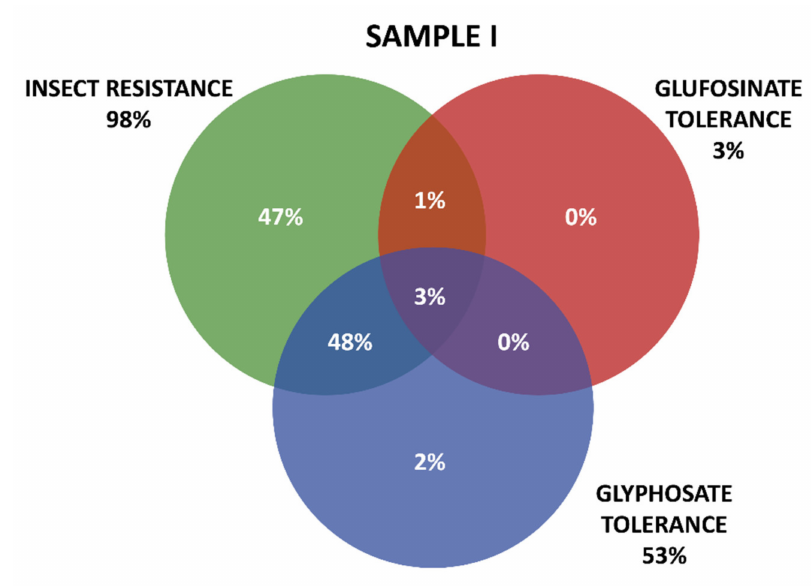
Figure 3. Detection and overlapping of GM proteins identified according to mode of action (insect resistance (IR) and tolerance to glufosinate ammonium (GAT) and glyphosate (GT) herbicides), Sample I.